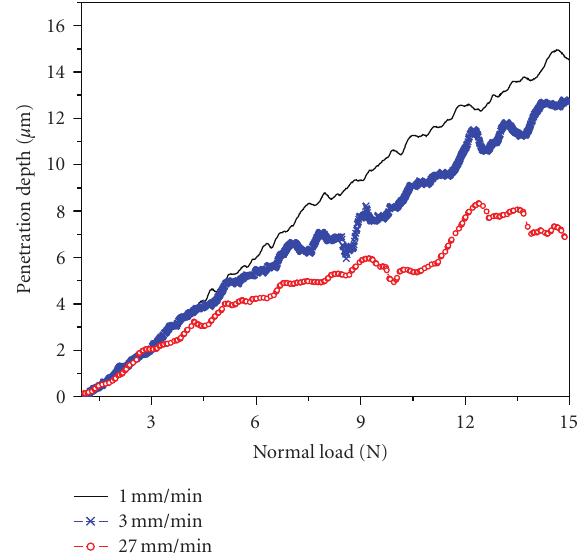
Figure 2: Indenter penetration depth at three di ff erent scratch speeds with increasing normal load.